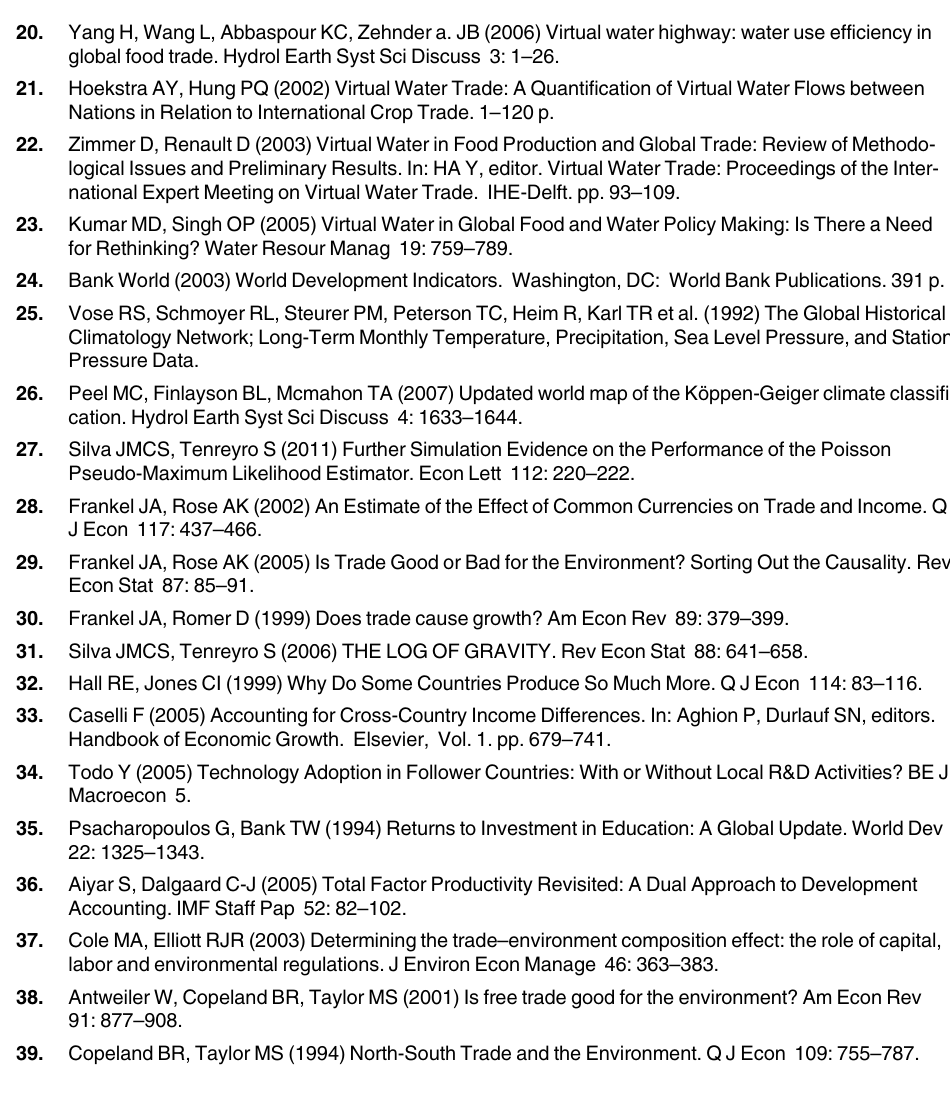
PLOS ONE | DOI:10.1371/journal.pone.0132133 July 13,